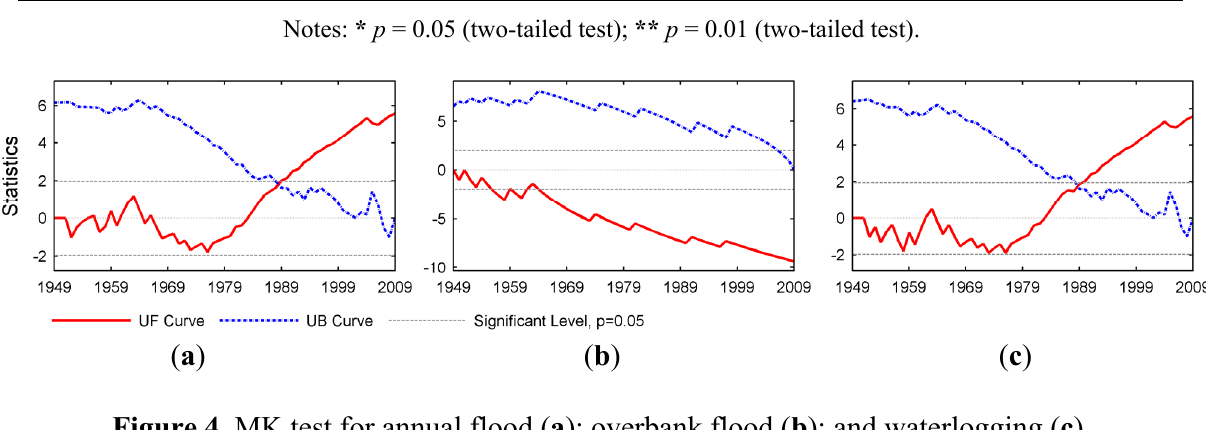
Figure 4. MK test for annual flood ( a ); overbank flood ( b ); and waterlogging ( c